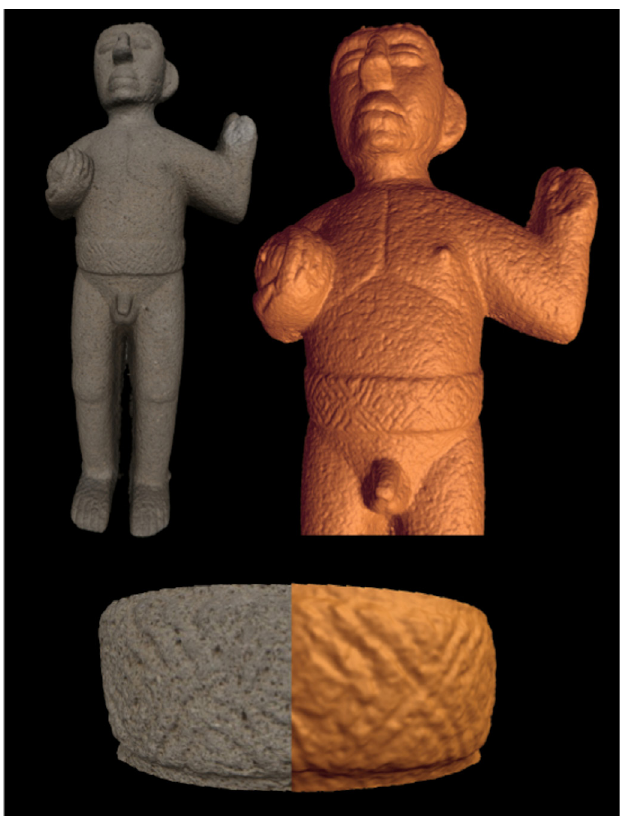
Fig. 3.10. Photogrammetry model of a Costa Rican Sacrificing Warrior (800–1300 AD) in Basalt (RMAH collections). The possibility of viewing the model without the texture has improved the visibility of the belt markings.